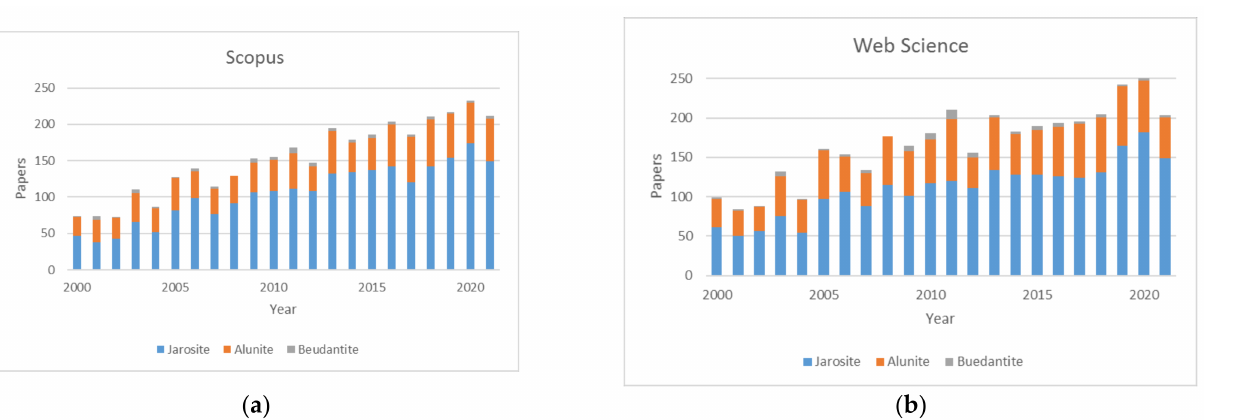
Figure 1. Number of papers with the terms “jarosite, alunite, beudantite” according to Scopus ( a , b ) Web of